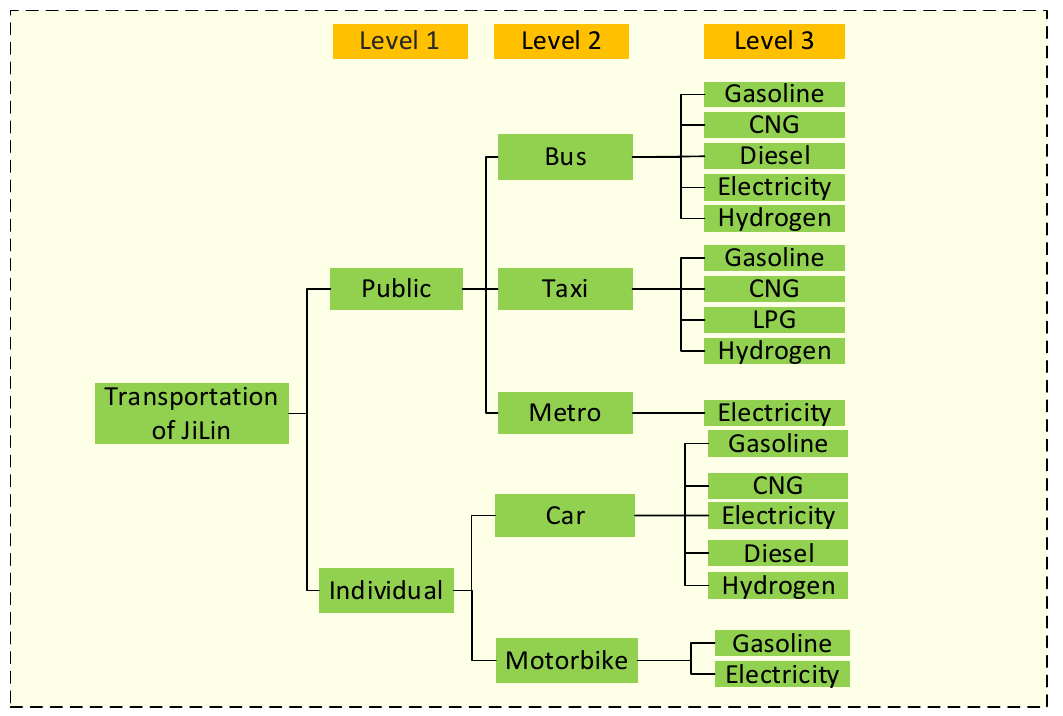
Figure 2. The structure of the LEAP model.